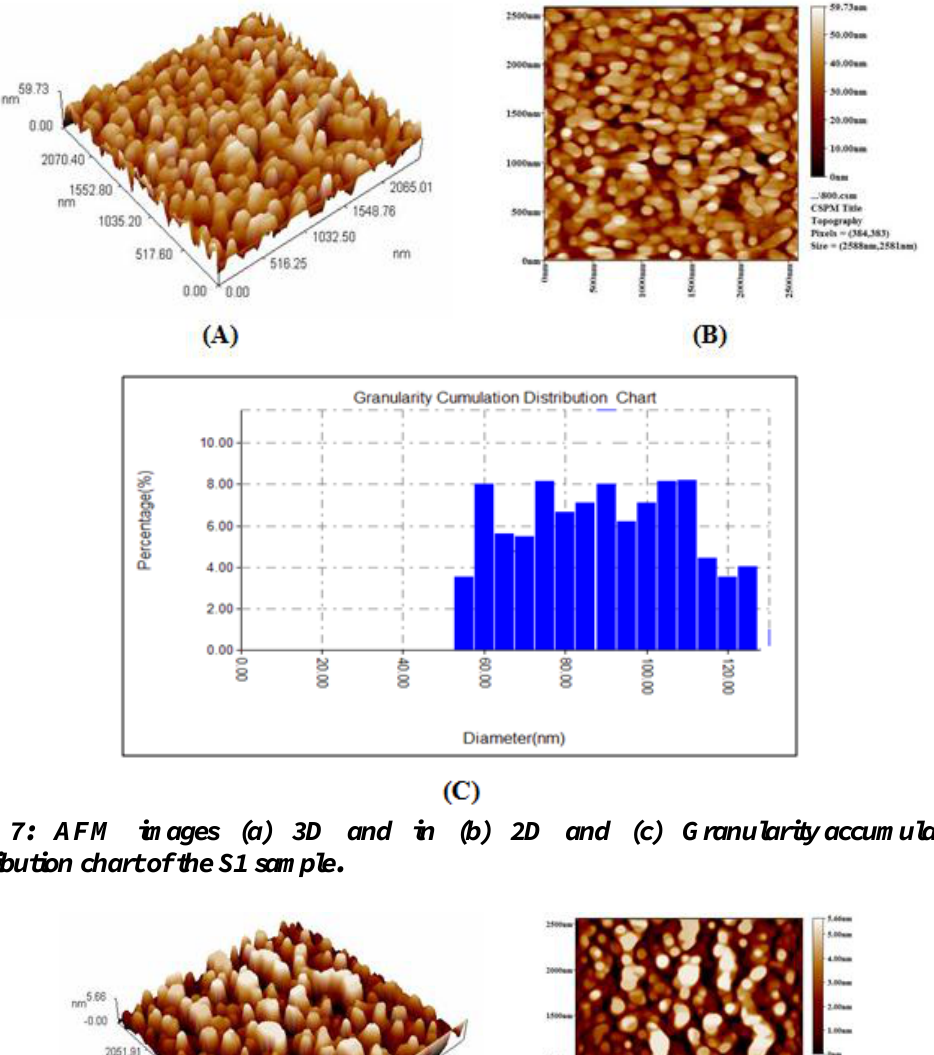
Fig. 7: AFM images (a) 3D and in (b) 2D and (c) Granularity accumulation distribution chart of the S1 sample.